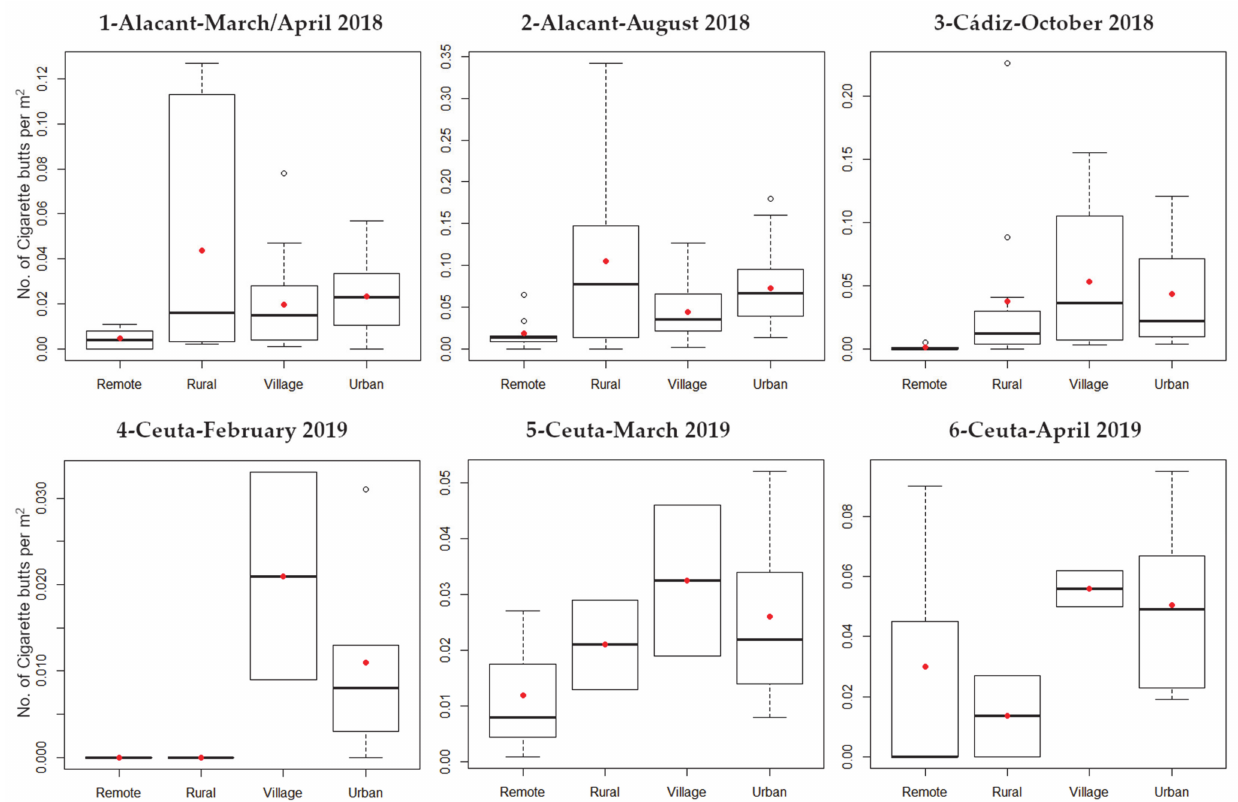
Figure A2. Box plots of cigarette butts density (CB/m 2 ) per beach typology in each one of the six